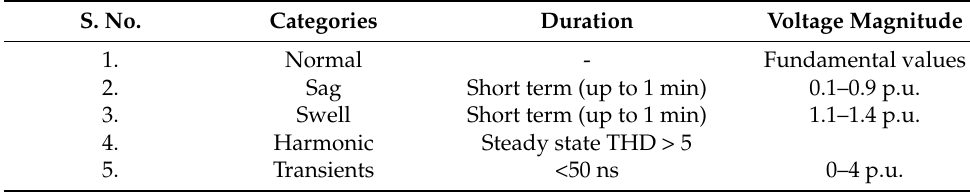
Table 1. Classification of power quality